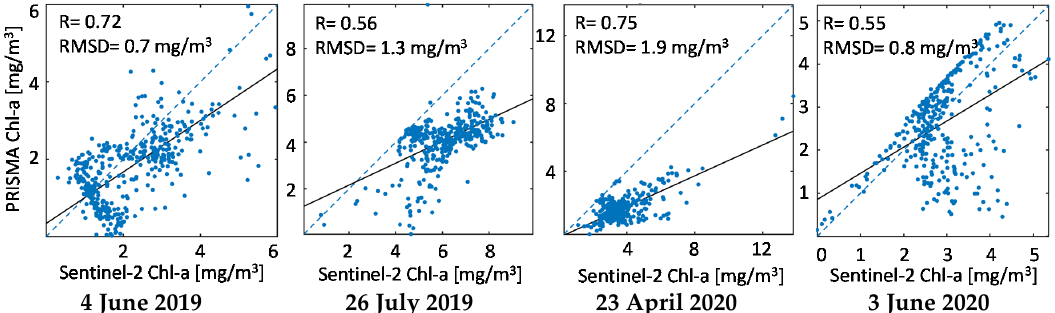
Figure 11. Agreement analyses among the Chl-a derived from PRISMA and Sentinel-2 images in terms of R and RMSD.